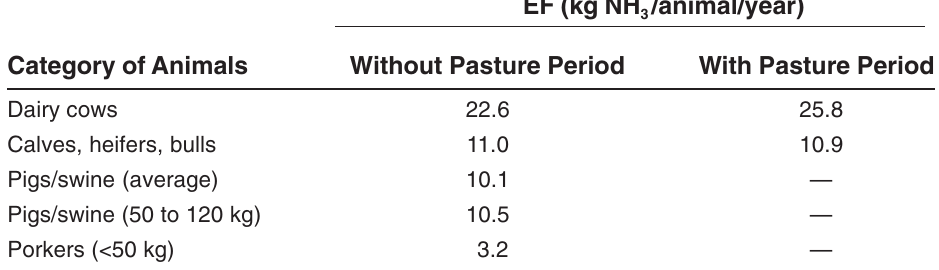
Emissions Factors for Cattle and 3